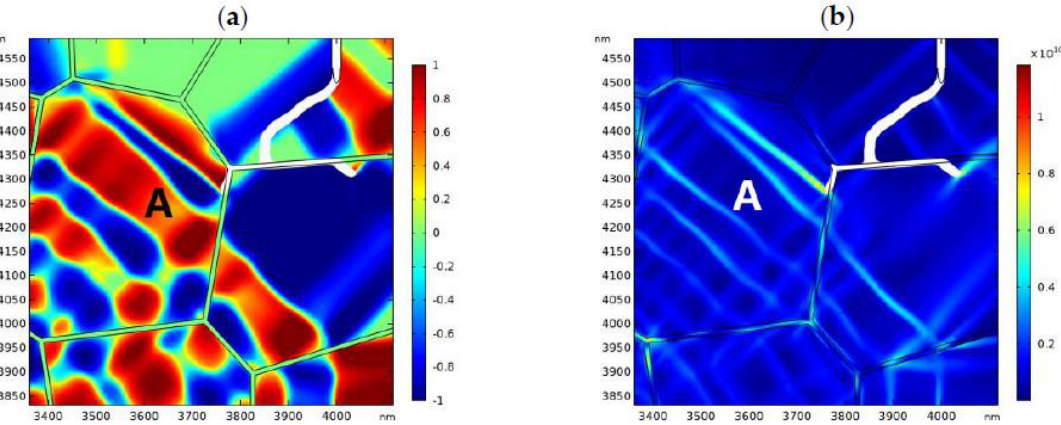
Figure 16. The local transformation pattern ( a ) and the local von Mises stress field ( b ) which correspond to the numerical results presented in Figure 15.